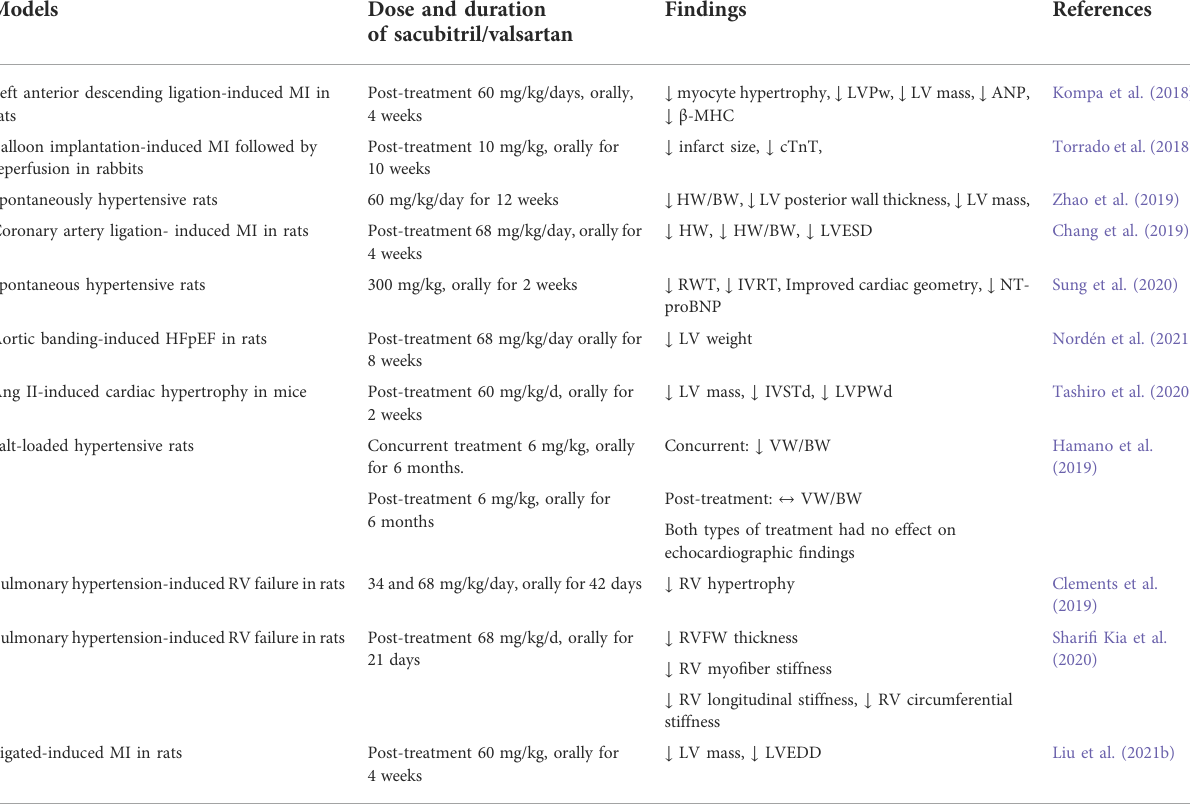
TABLE 4 The effects of sacubitril/valsartan on cardiac structure and biomarkers of cardiac hypertrophy in animal studies.